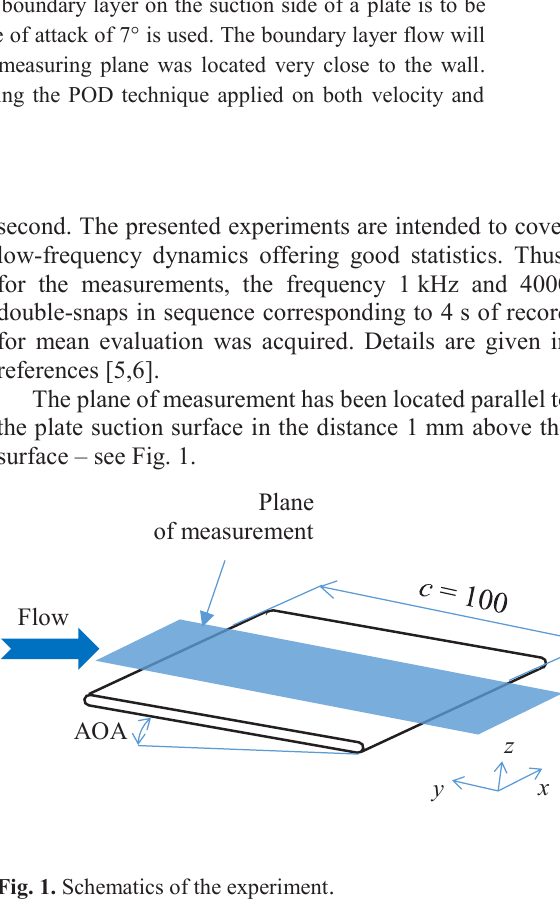
Fig. 1. Schematics of the experiment